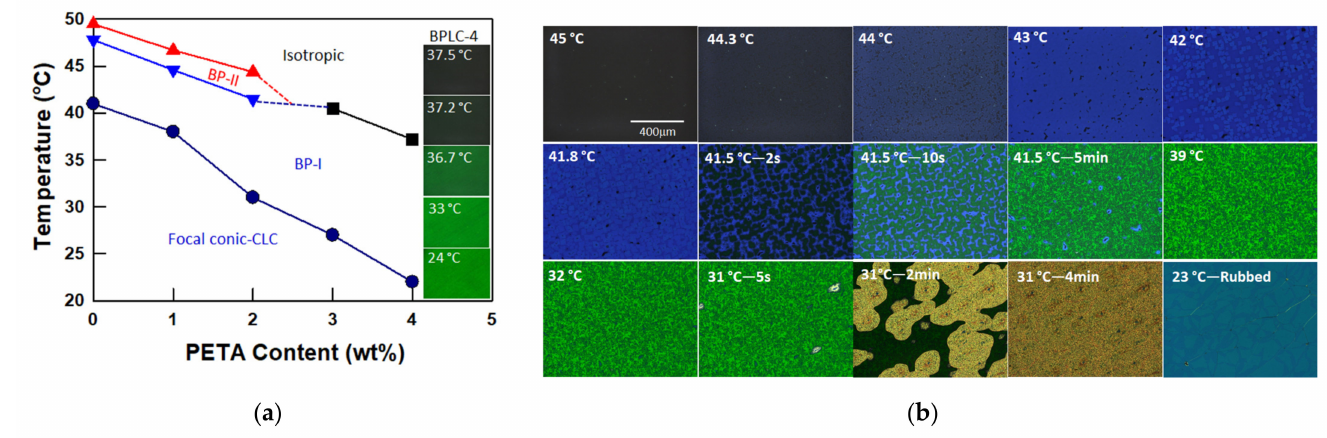
Figure 4. ( a ) Phase diagram: phase transition temperatures as a function of PETA concentration obtained from an Ocean Optics spectrometer and POM measurements. Insets are POM images of BPLC-4 on cooling. ( b ) POM images of BPLC-2 on cooling at a rate of 0.1 ◦ C min − 1